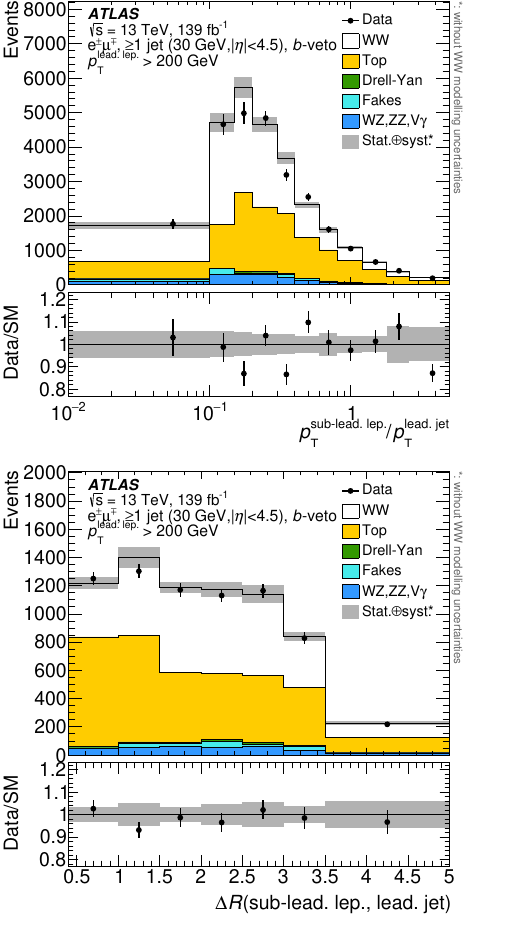
Figure 10 . Signal region detector-level distributions, requiring p lead. lep. > 200 GeV, of T (top left), p sub-lead. lep. (top right), ∆ R ( sub-lead. lep. , jet ) (bottom p sub-lead. lep. /p lead. jet /p lead. lep. T T T T left) and ∆ φ ( sub-lead. lep. , jet ) (bottom right). Data are shown as black markers together with the predictions for the signal and background production processes. The last bin contains overflow events. The lower panels show the ratio of the data to the total prediction. The uncertainty bands shown include statistical and systematic uncertainties, excluding theory uncertainties on the